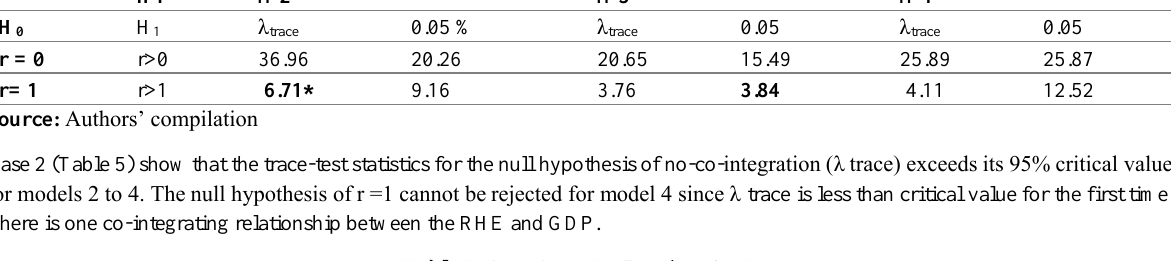
Table 5: Case 2- LNRHE and LNGDP